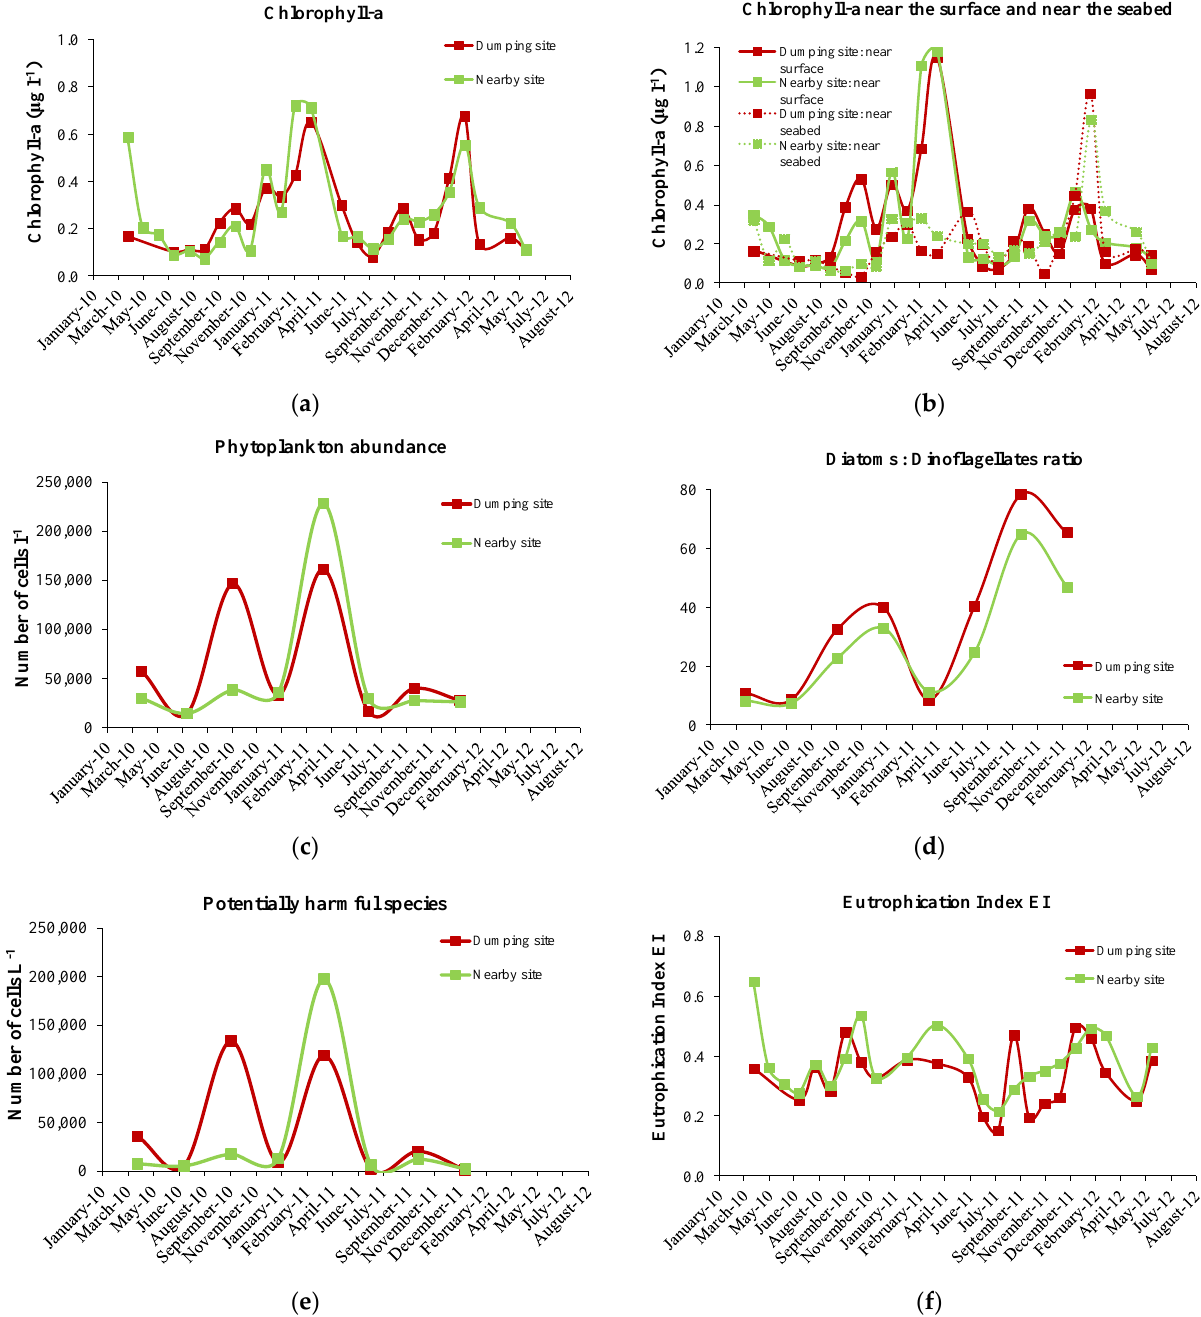
Figure 3. Distribution of phytoplankton parameters during the monitoring survey for the dredge spoil dumping in coastal waters (‘Dumping site’ is DSS1, DSS2 and ‘Nearby site’ is DSS3, DSS4, –DSS5): Chlorophyll-a ( a ), Chlorophyll-a near the surface and near the seabed ( b ), phytoplankton abundance ( c ), Diatoms:Dinoflagellates ratio ( d ), potentially harmful species ( e ) and Eutrophication index EI ( f ). Values are averaged from surface and bottom.